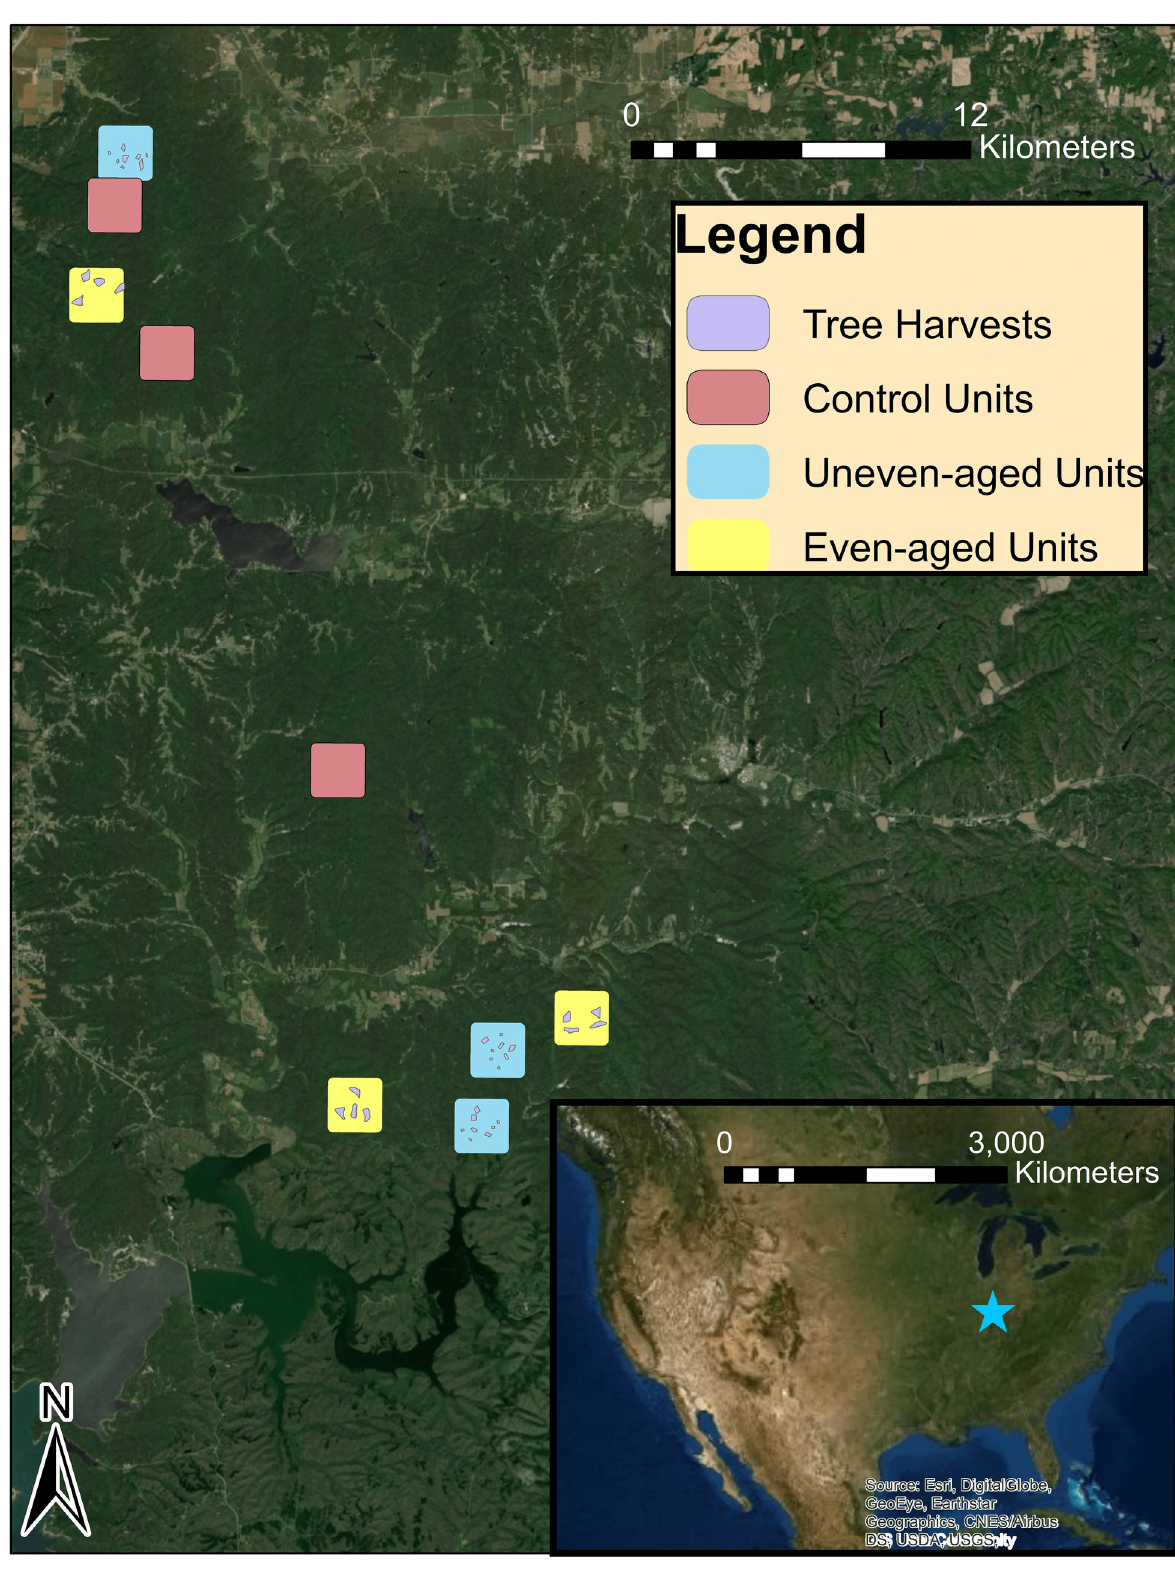
Fig 1. Hardwood ecosystem experiment study units. Research on roost habitat selection in Cerulean Warblers ( Setophaga cerulea , Wilson) was conducted at 9 research sites in Morgan-Monroe and Yellowwood state forest in Morgan, Monroe, and Brown counties, southern Indiana during May-June, 2017. Three units are managed as even-aged forests, three managed as uneven-aged forests, and three units are control sites with no forest management practices. https://doi.org/10.1371/journal.pone.0241501.g001 PLOS ONE | https://doi.org/10.1371/journal.pone.0241501 November3, 2020 3 /